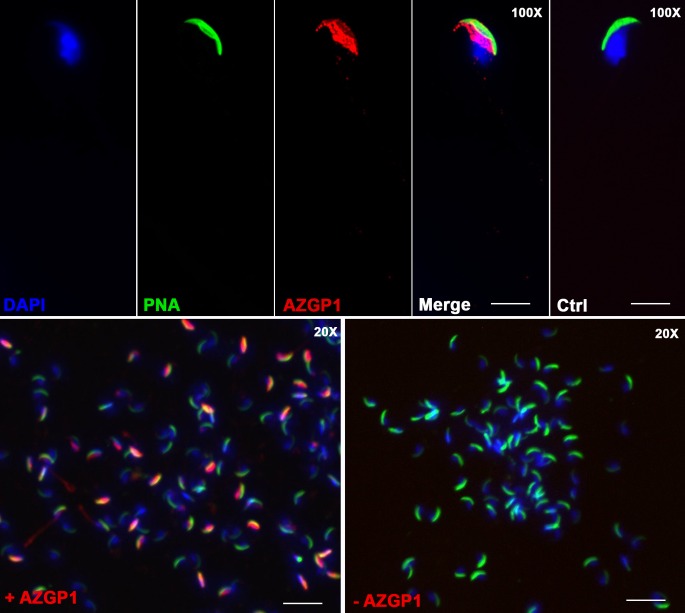
Localization of Zinc-alpha-2-glycoprotein (AZGP1) on spermatozoa from wild type mice.Sperm acrosomal region and nuclei were labelled with Peanut agglutinin lectin (PNA) and DAPI, respectively. Pictures were taken at 100X (top) and 20X (bottom) after immunostaining in the presence (+ AZGP1) or absence (Ctrl,—AZGP1) of antibody against AZGP1. Bars = 5 μm (top) and 20 μm (bottom).